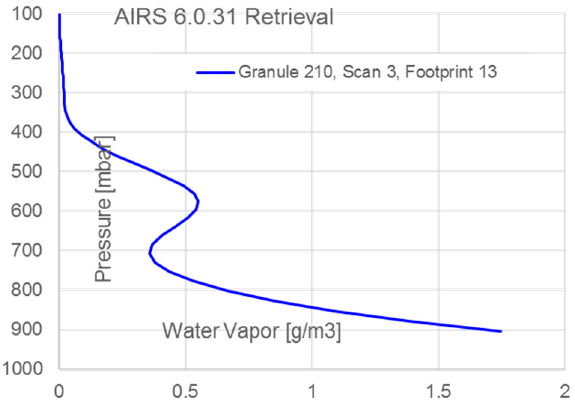
Figure 16. AIRS water vapor retrievals for a cloud-free sounding closest to the Edwards Air Force Base radiosonde and MISTiC airborne data. The area of high water vapor concentration peaking near 560 hPa (4546 m) is consistent with the Edwards radiosonde data in Figure 15 and the presence of a higher-altitude region of higher water vapor concentration apparent in the images in Figure